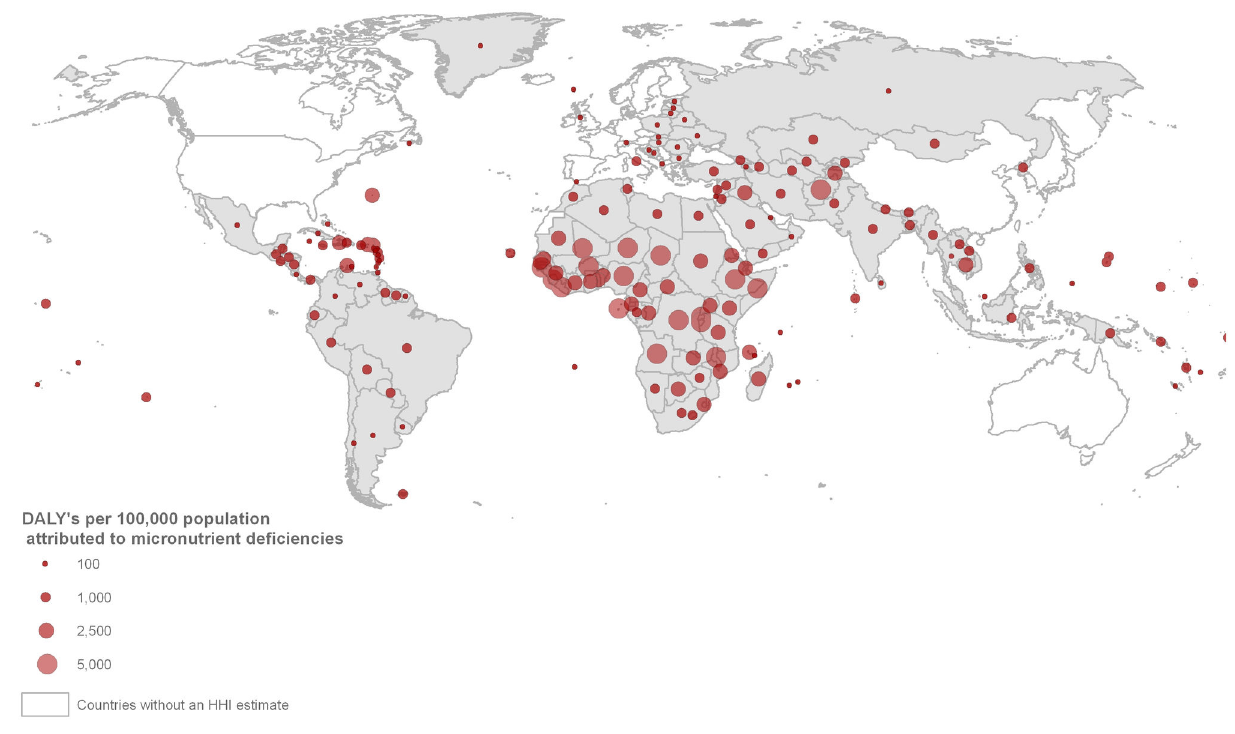
Figure 5. Global map presenting the population-adjusted hidden hunger associated